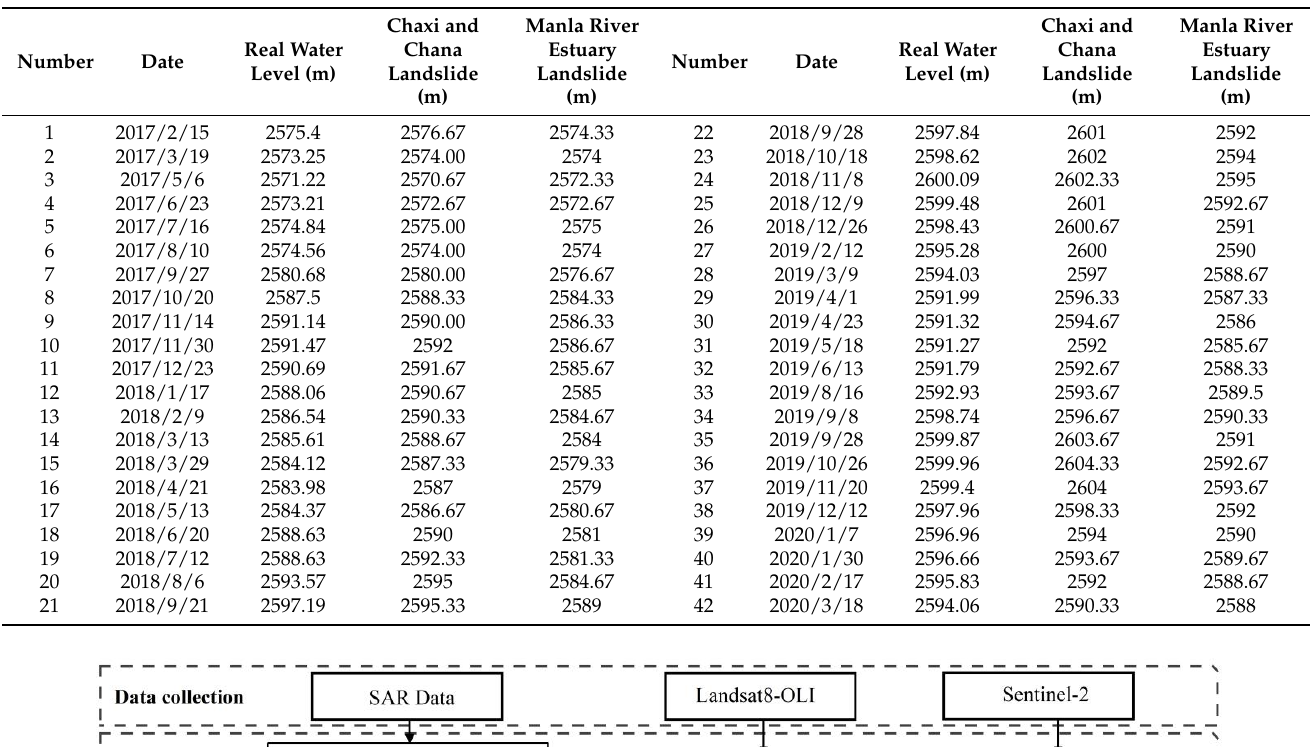
Table 4. Water levels of Chaxi, Chana, and Manla River Estuary landslides in the Longyangxia reservoir area.